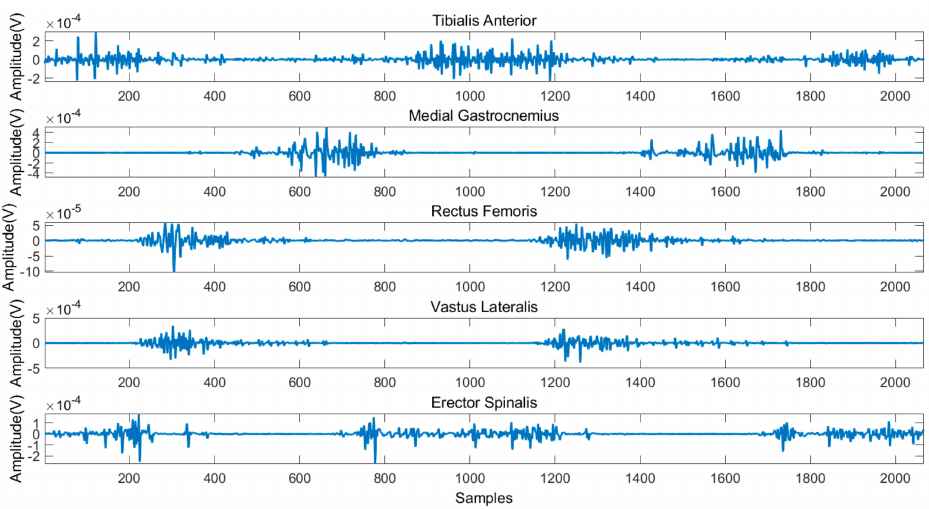
Figure 5. Typical sEMG signals during walking up the stairs.